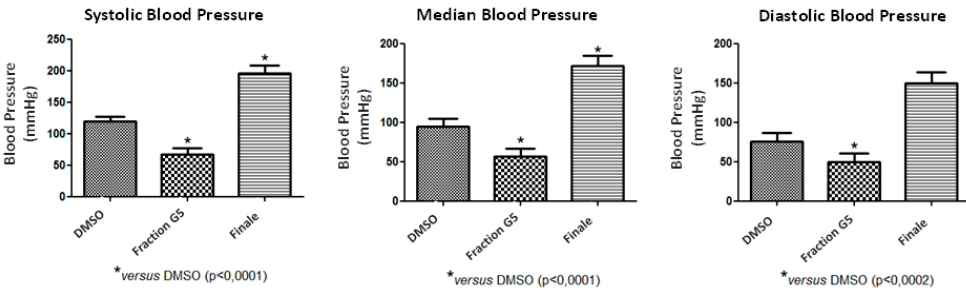
Figure 3. Effects of the G5 fraction (30 mg/kg) from Schinus terebinthifolius Raddi fruit extract on the blood pressure of Wistar rats. Systolic blood pressure (SBP), median blood pressure (MBP), diastolic blood pressure (DBP). The values are expressed as mean ± SEM from eight experiments. One-way ANOVA followed by Newman-Keuls test (* p < 0.05 compared to control).